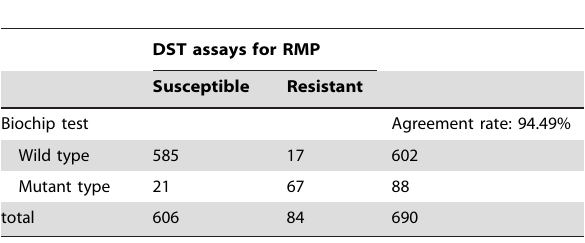
Table 2. Comparison of DST and biochip for isoniazid resistance pattern *